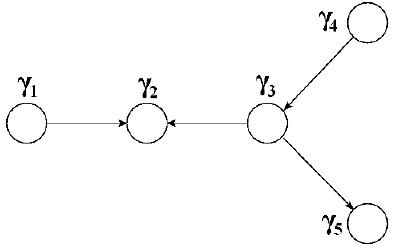
Figure 17. A BPS quiver for the ( A 1 ; D 5 ) Argyres-Douglas theory.